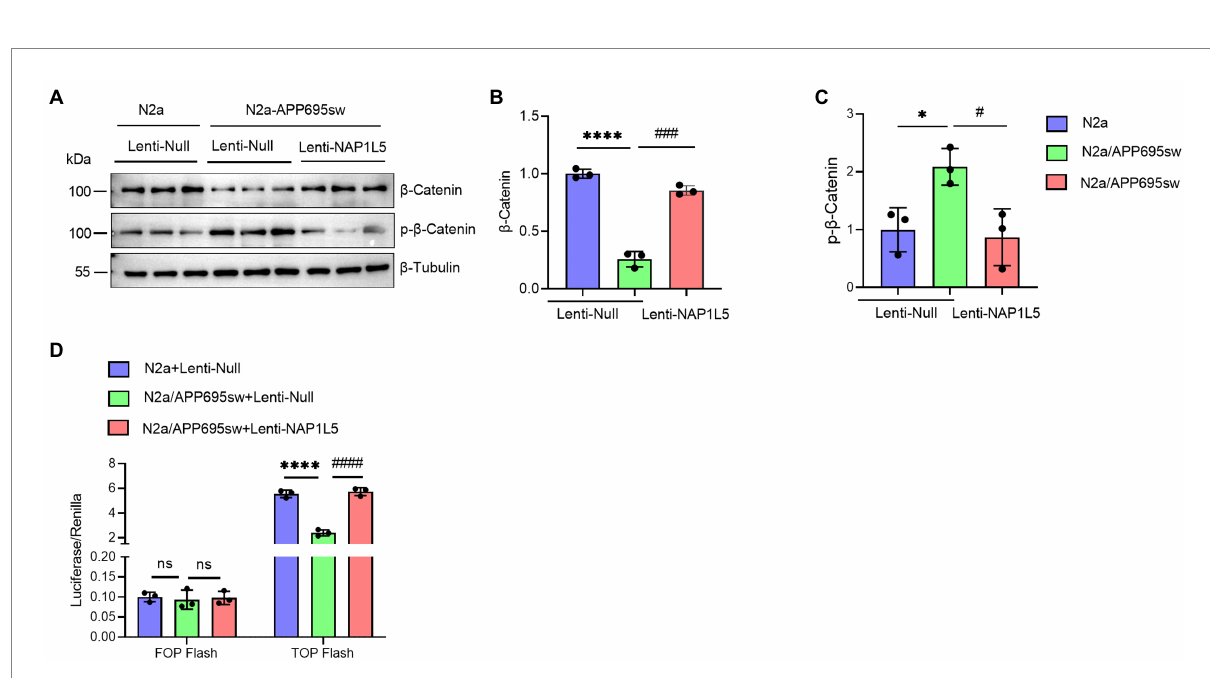
FIGURE 4 NAP1L5 overexpression activated the Wnt/ β -Catenin signaling pathway in N2a-APP695sw cells. (A–C) , N2a and N2a-APP695sw cells were stably infected lenti-Null or lenti-NAP1L5. The β -Catenin and phosphorylated β -Catenin levels were detected using Western blotting (A) , and then quantified (B,C) . (D) The activation of the Wnt/ β -Catenin signaling pathway was assured using the TOP/FOP flash assay. Data are presented as mean ± SD, n = 3. ∗ p < 0.05; ∗∗∗∗ p < 0.0001 for N2a-APP695sw (lenti-Null) versus N2a (lenti-Null). # p < 0.05, ### p < 0.001; #### p < 0.0001 for N2a- APP695sw (lenti-NAP1L5) versus N2a-APP695sw (lenti-Null); ns, not significant. The student’s t -test was